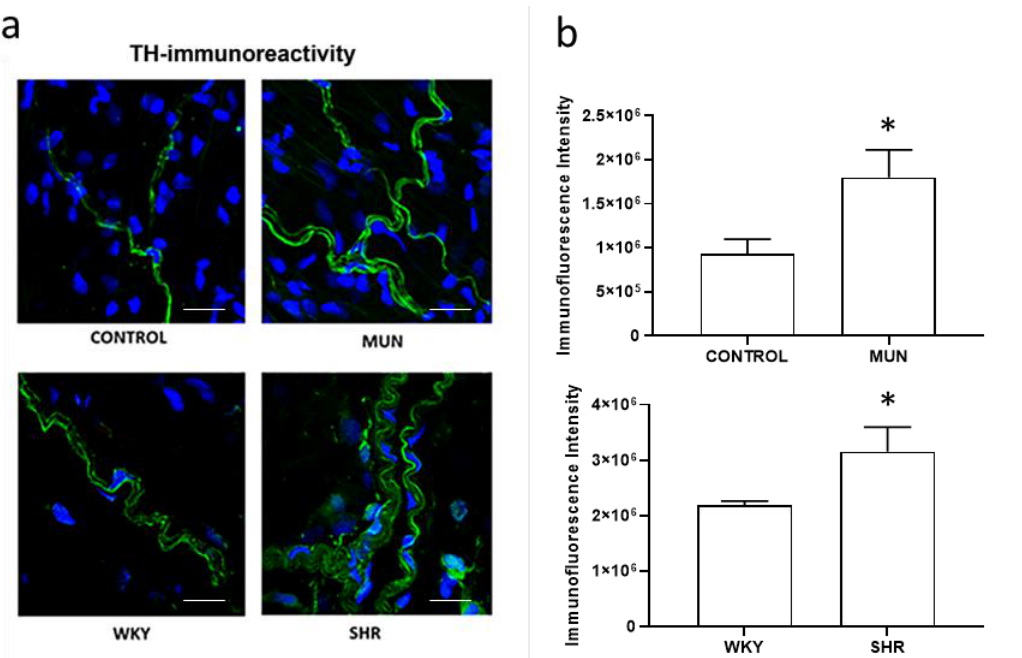
Figure 6. ( a ) Laser scanning confocal microscopy representative images of the adventitia layer of mesenteric arteries from CONTROL and MUN (upper panel) WKY and SHR (lower panel) rats. Images show the immunofluorescence reactivity to TH (green) with DAPI-stained nuclei (blue). Scale bar: 25 μm. ( b ) Quantitative analysis of LSCM images. MUN, offspring exposed to maternal undernutrition during pregnancy; CONTROL, offspring from mothers fed ad libitum during pregnancy; SHR, spontaneously hypertensive rats; WKY, Wistar Kyoto rats. In the graphics, values are mean ± s.e.m. from 6 rats from each group. Significant differences from the respective control rats: * p < 0.05.